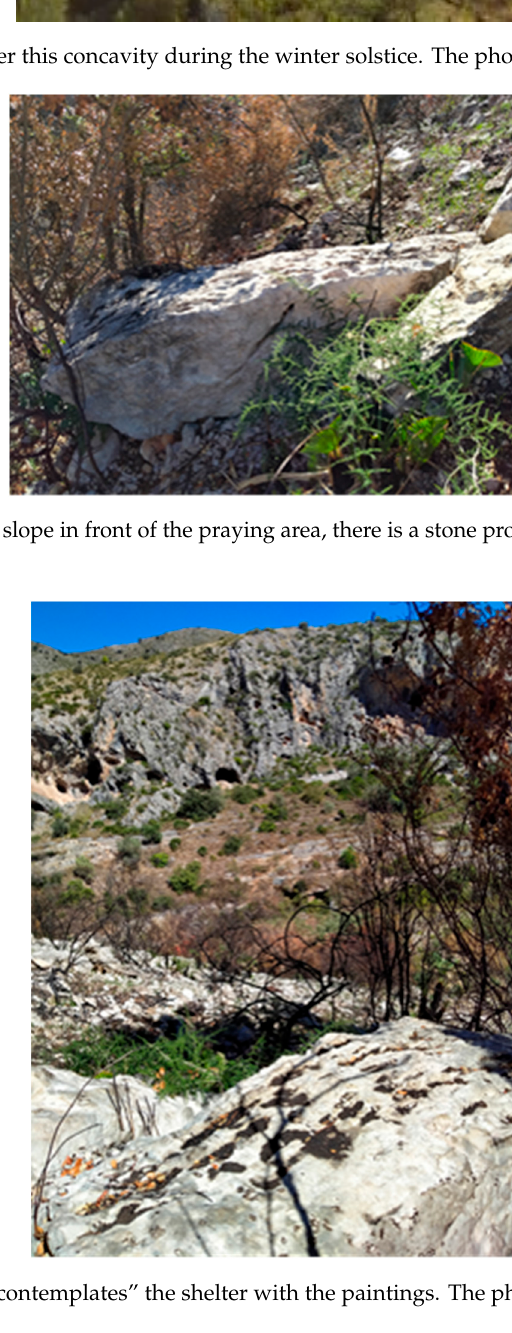
Figure 14. The stone “contemplates” the shelter with the paintings. The photo is taken by the author.